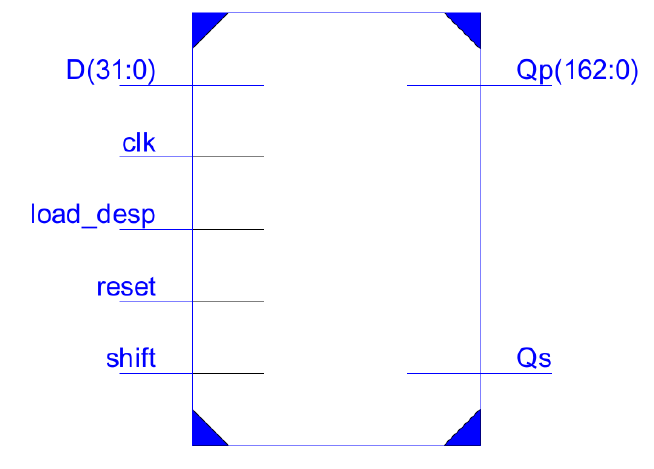
Figure 3. reg_interface I/O.